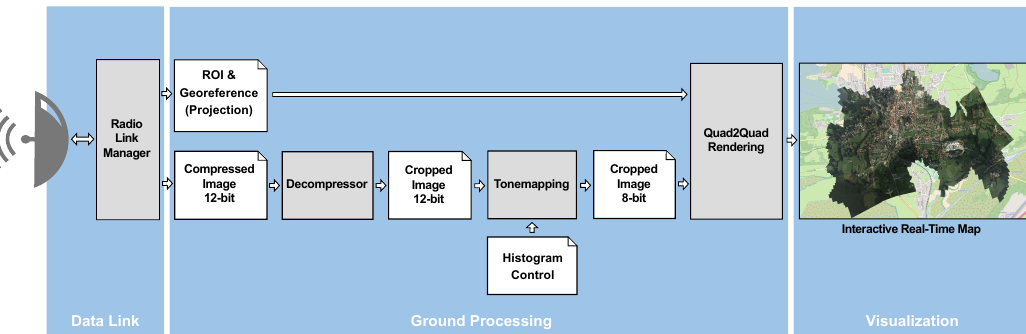
Figure 2. Ground segment of real-time processing chain. The quad2quad rendering stage is explained in Section